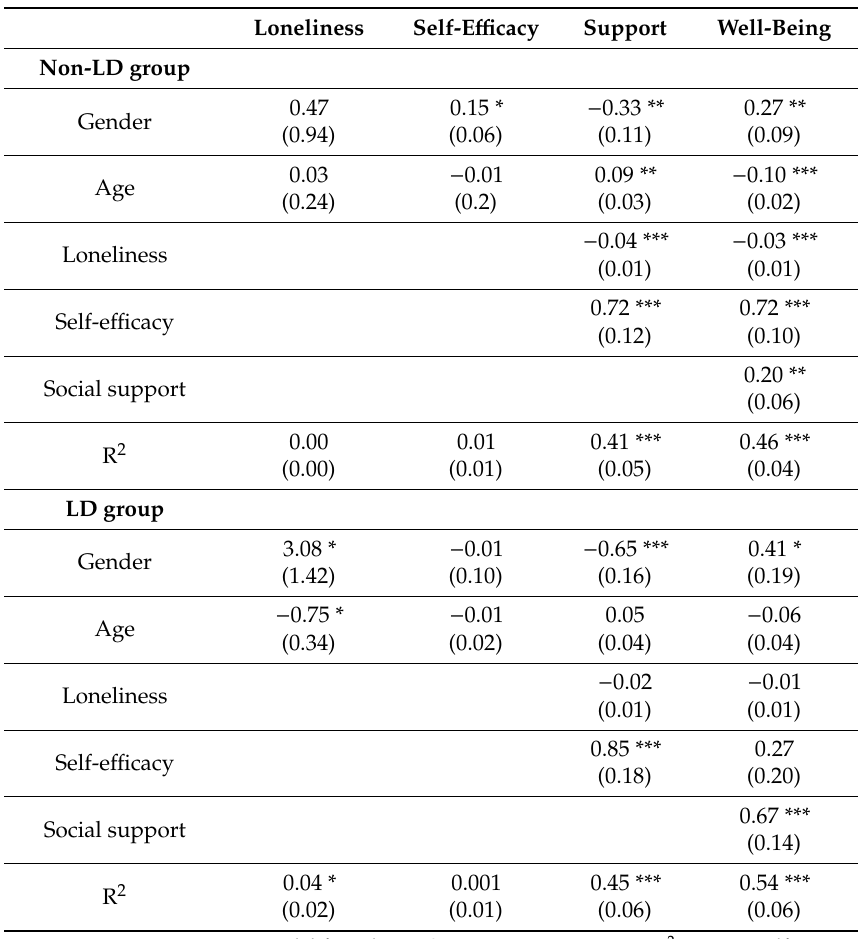
Table 4. Model estimates by group, unstandardized coe ffi